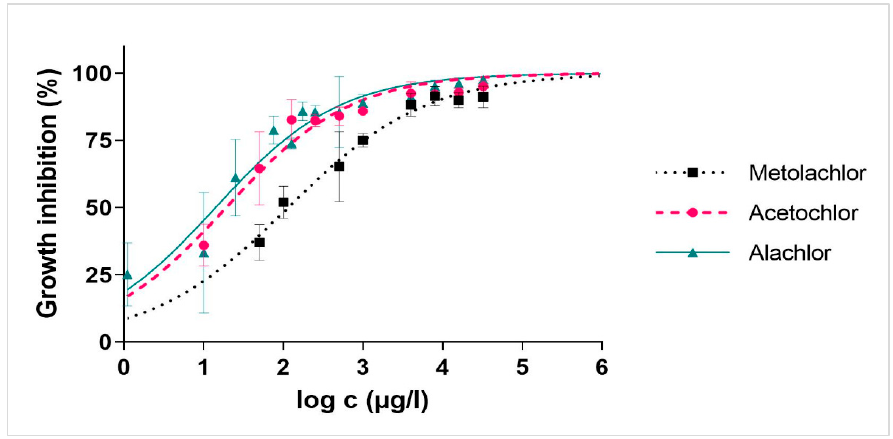
Figure 2. Estimation of dose–response curves describing the toxicity of tested chloroacetanilide herbicides to Chlorella kessleri after 72 h of exposure. Table 1. Estimated 72 h EC 50 values ( μ g/L) of tested chloroacetanilide herbicides to Chlorella kessleri with 95% confidence intervals in brackets.